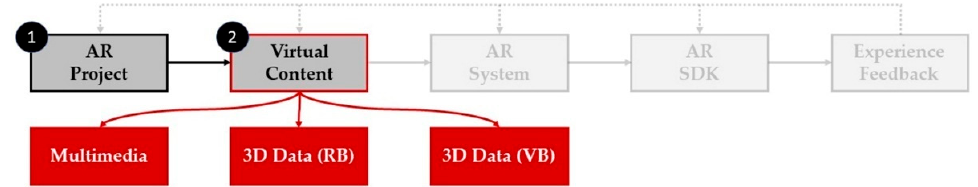
Figure 8. Block diagram of the main features of the virtual content creation.